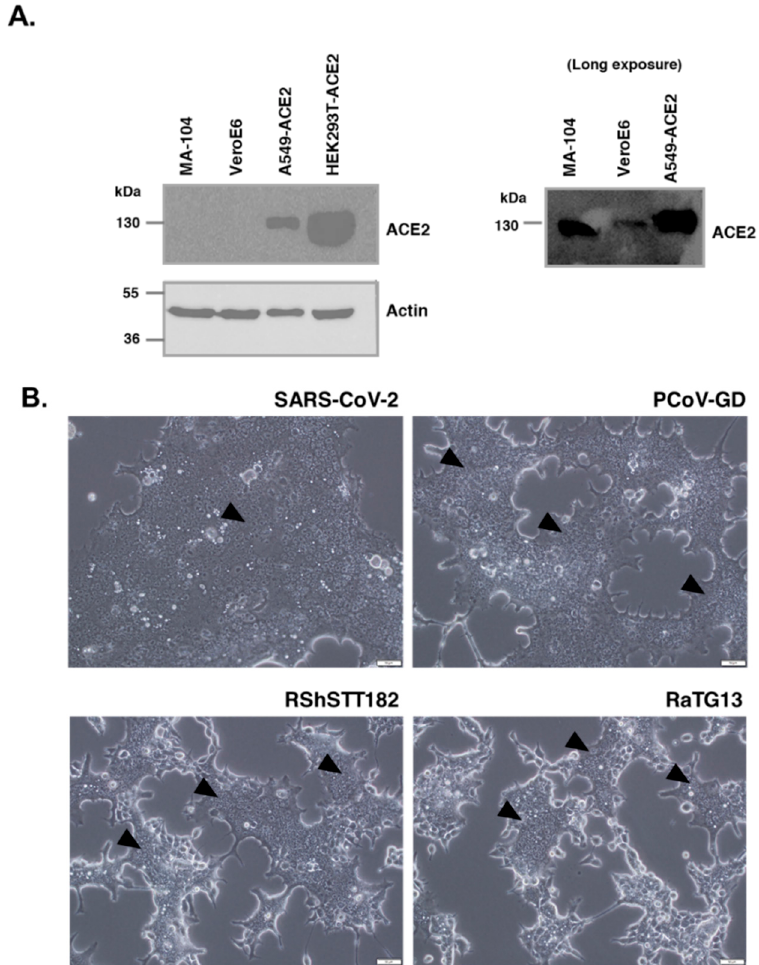
Figure 3. Spike of RaTG13 could trigger cell–cell fusion in cells strongly expressing human ACE2. ( A ). The level of ACE2 expression in cell lines susceptible to SARS-CoV-2 infection. Using antibodies against human ACE2, Western blot analysis of lysates from each cell line was performed. Beta-actin expression served as a loading control. To detect ACE2 expression in VeroE6 cells, a longer exposure time was used and the lane of HEK-293T-ACE2 was excluded. ( B ) . Cell–cell fusion in HEK293T-ACE2 cells transfected with each variant of the spike protein in the presence of trypsin. Images were taken 24 h following transfection using an inverted light microscope (scale bar of 100 µ m). The black arrows indicate areas where cell–cell fusion was